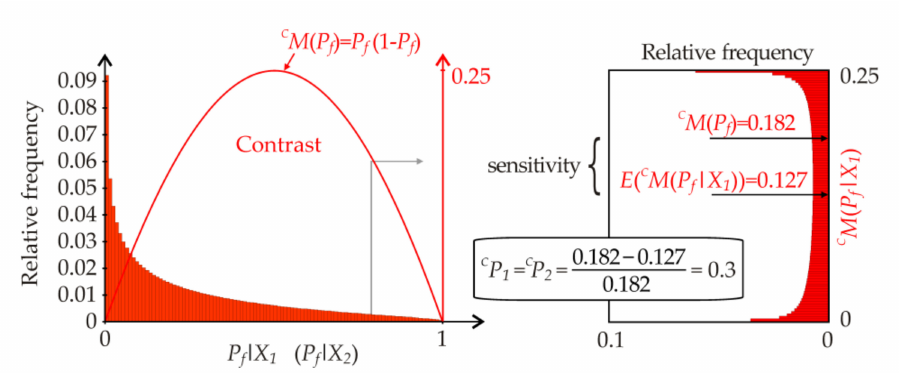
Figure 4. The contrast-based sensitivity measure C M ( P f ).